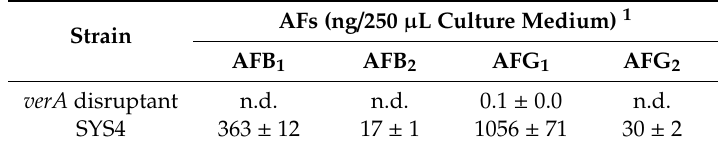
Table 2. Aflatoxin production by verA deletion mutant and its wild strain.